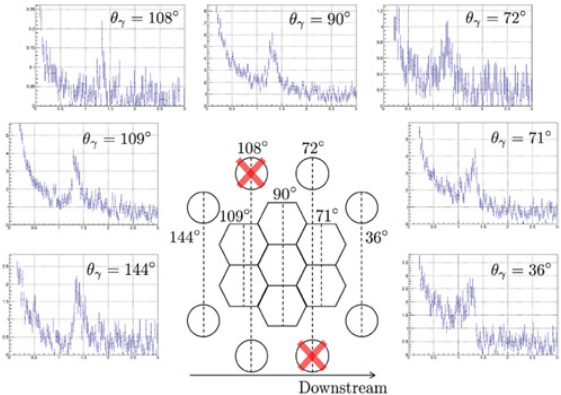
Figure 3. The neutron energy spectrum around the 1.33eV p-wave resonance in 118 Sn, for the various angles accessible at ANNRI. The central figure shows the placement and the shape of each crystal. The detectors marked by red crosses were not available for our experiment.